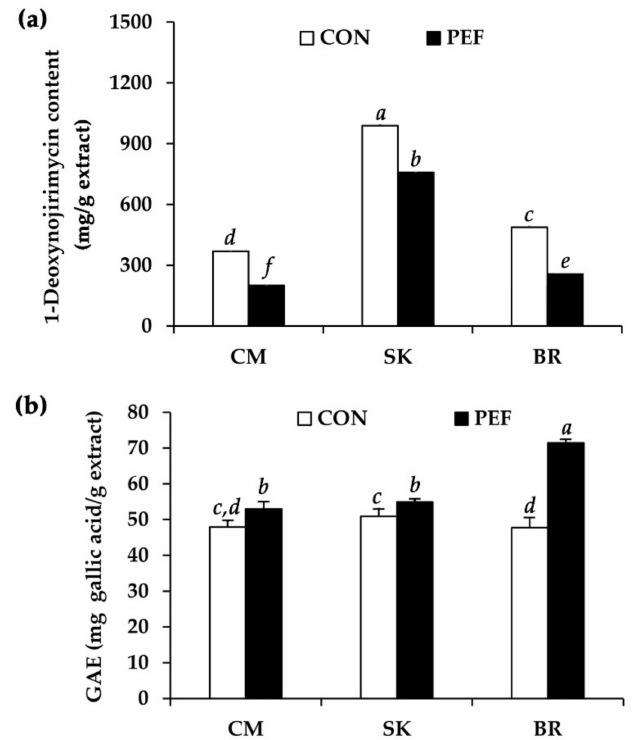
Figure 3. ( a ) 1-Deoxynojirimycin content and ( b ) total phenolic content, expressed as gallic acid equivalent (GAE), of M. alba leaf extract from Chiang Mai (CM), Sakon Nakhon (SK), and Buriram